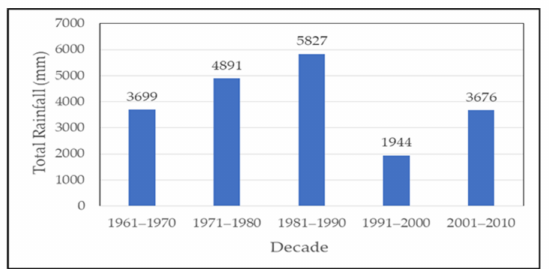
Figure 4. Decadal variation in rainfall in the pre-monsoon summer season at Dhaka.